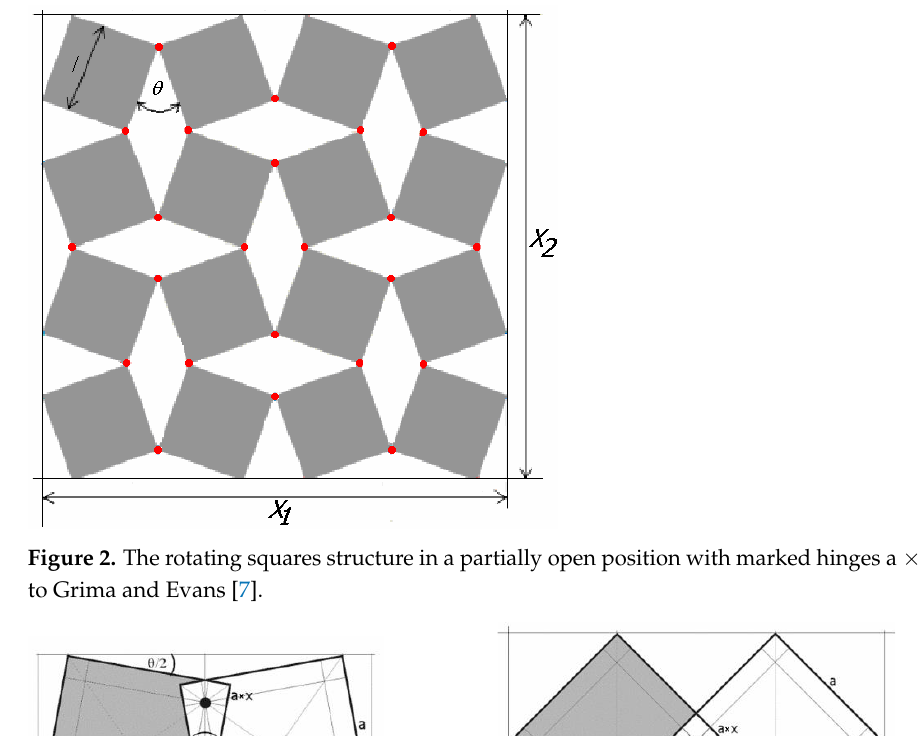
Figure 2. The rotating squares structure in a partially open position with marked hinges a  x similar to Grima and Evans [7].